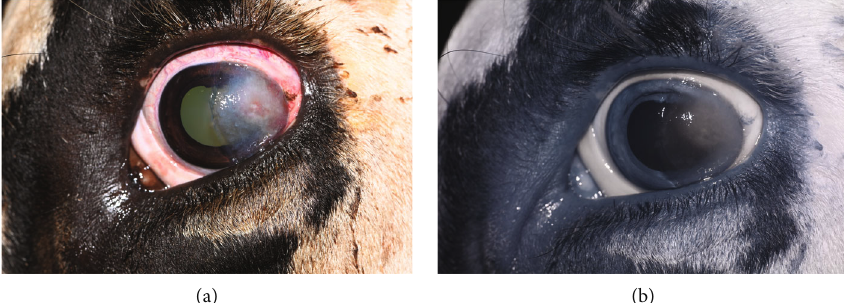
Figure 4: Color (a) and infrared (b) imaging of the left eye 1 week after surgery. Granulation of the keratectomy site is noted with no evidence of tumor regrowth.